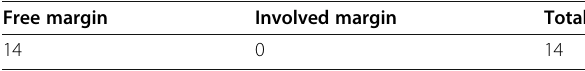
Table 2 Classifications of patients according to preoperative MDCT criteria